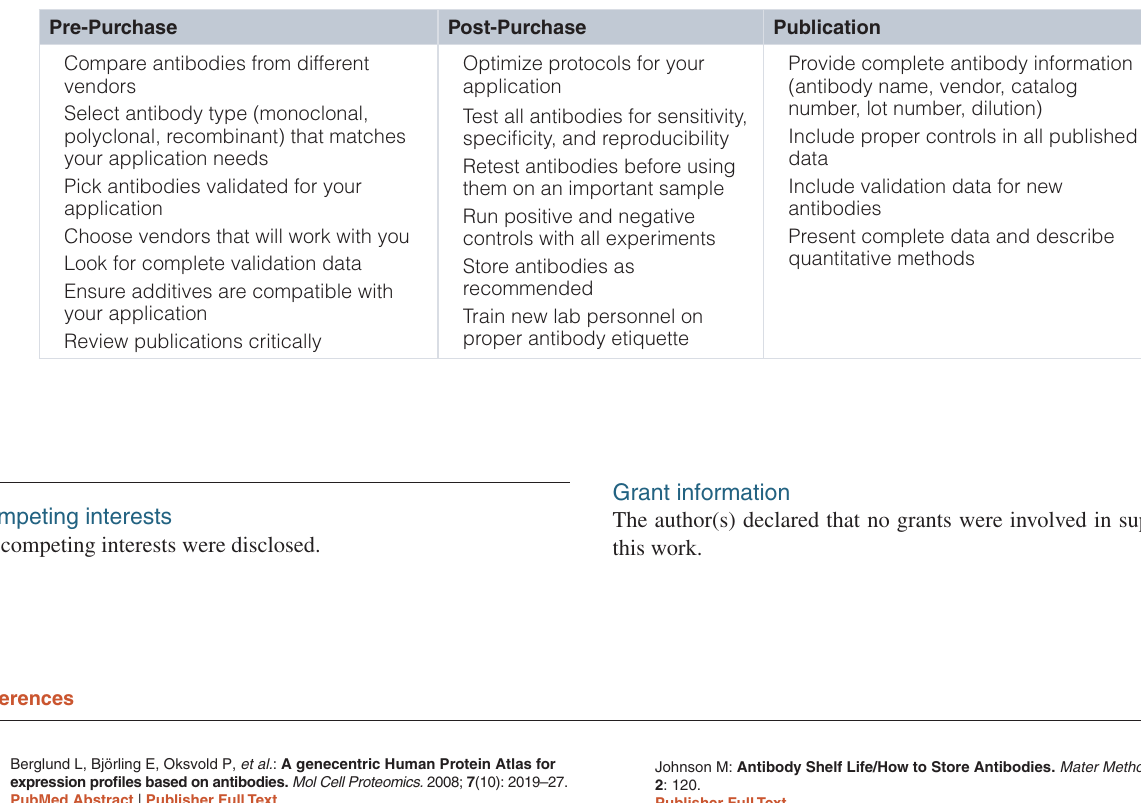
Table 1. Antibody best-practice